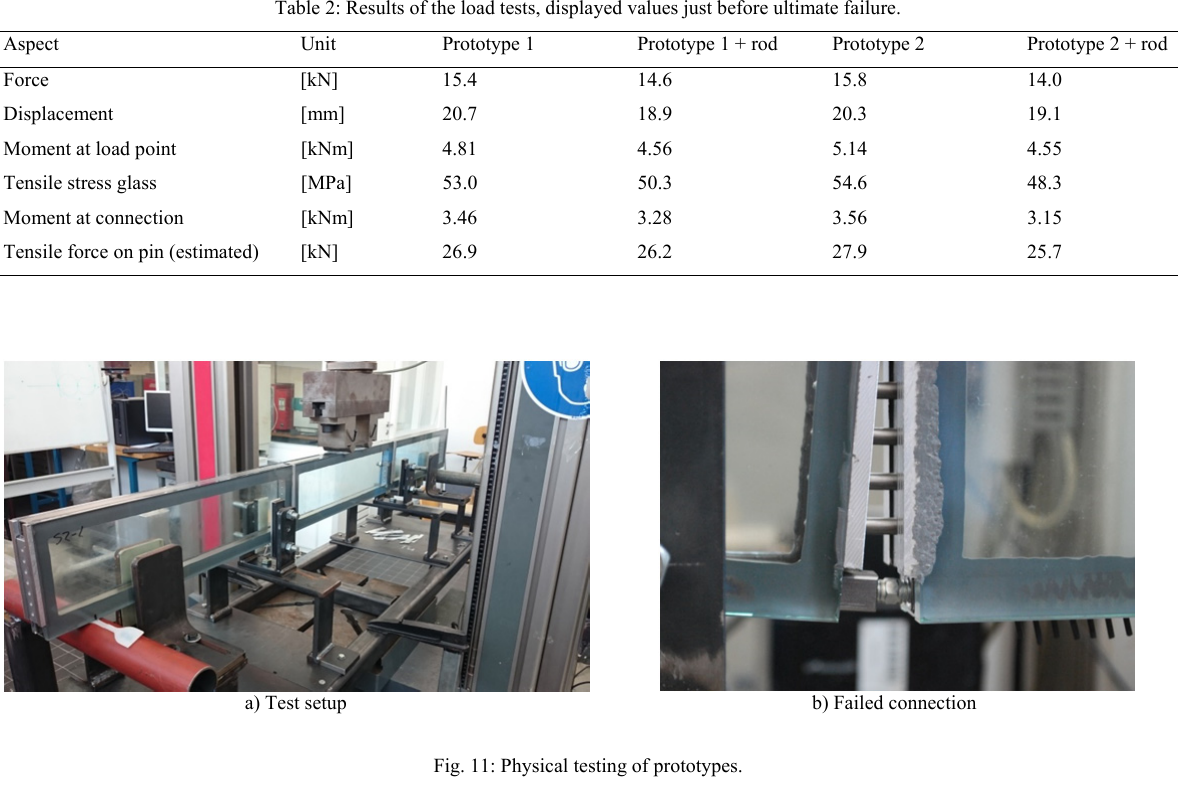
Fig. 11: Physical testing of